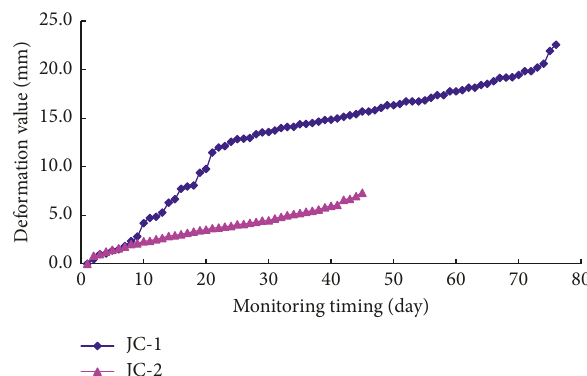
Figure 3: Actual measurement data of JC-1 and JC-2 monitoring points of a deep foundation pit slope.